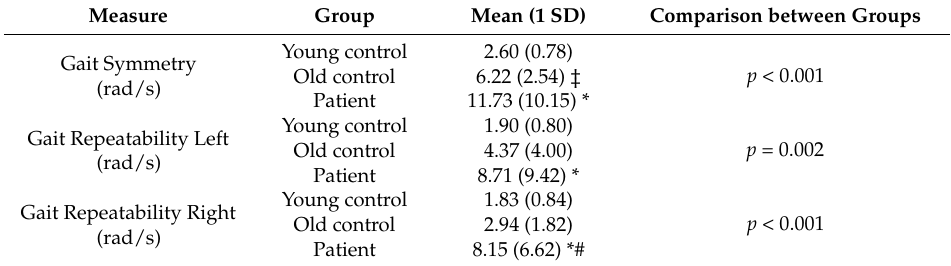
Table 4. Group comparison of gait regularity variables with the eyes open condition.